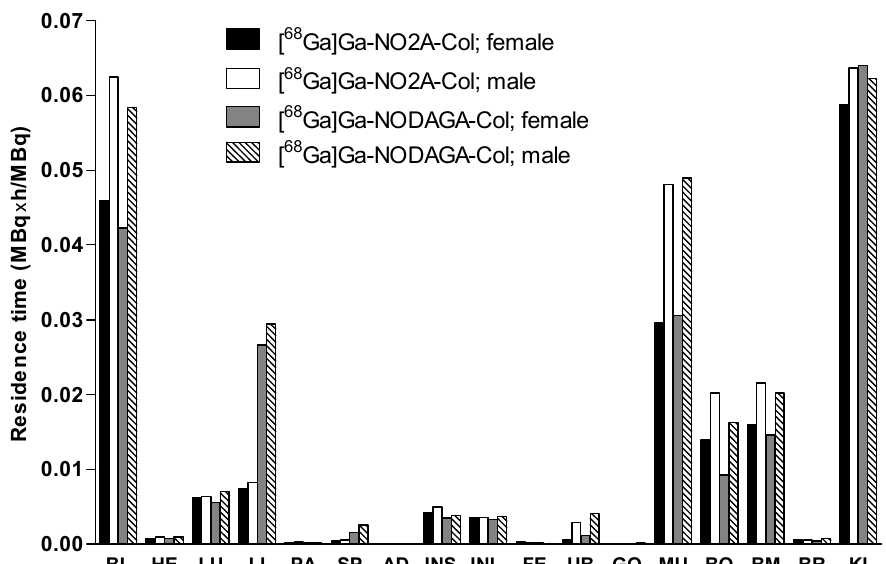
Figure 4. Graph showing the residence times of [ 68 Ga]Ga-NO2A-Col and [ 68 Ga]Ga-NODAGA-Col in different organs. The values were extrapolated to human female and male from rat ex vivo organ distribution data and used for dosimetric calculations using the OLINDA/EXM 1.1 software. BL: blood;